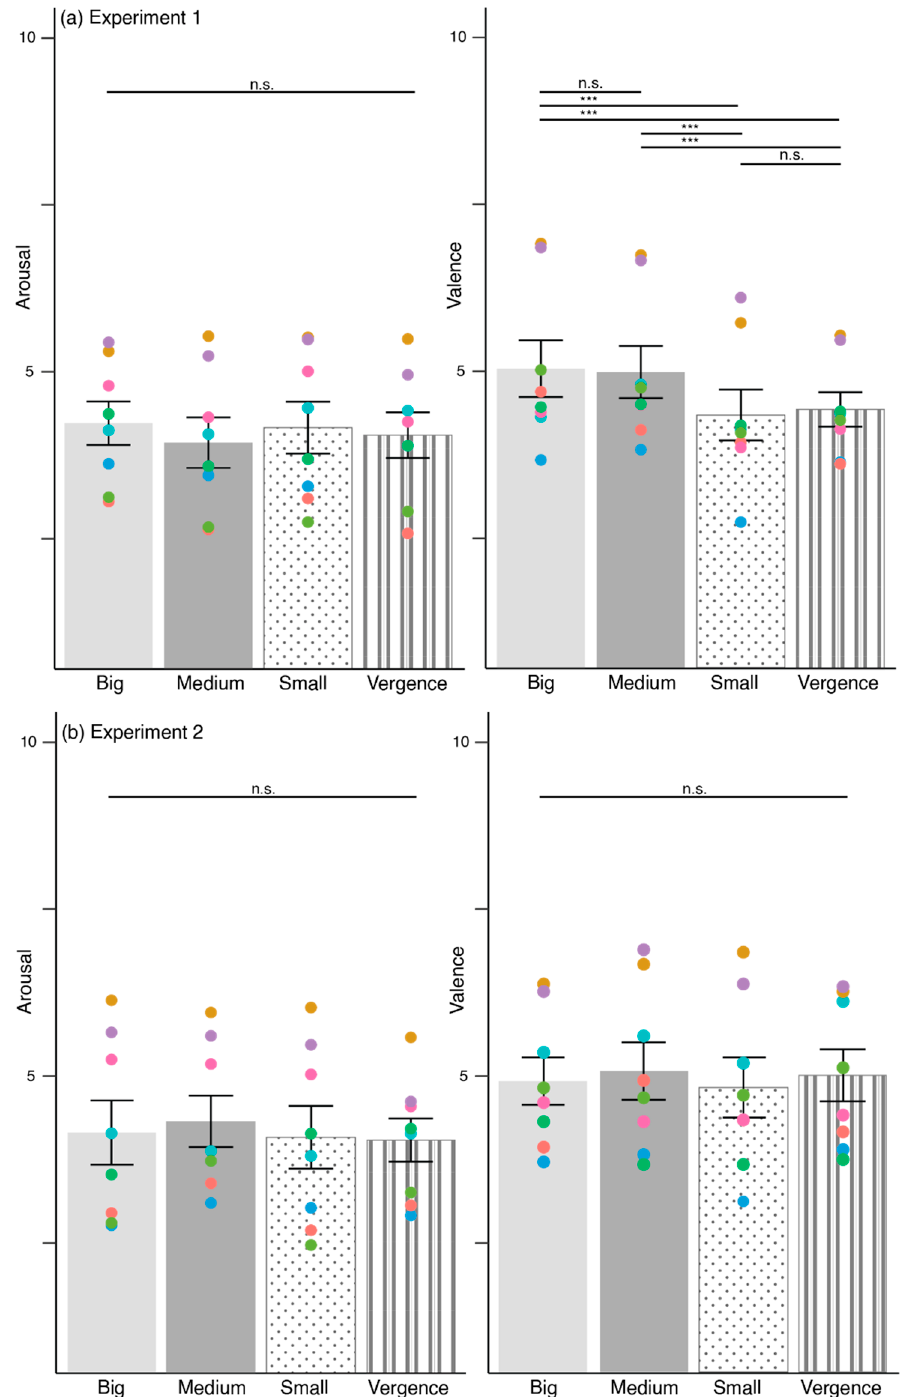
Figure 7. Arousal and valence ratings in ( a ) Experiment 1, and ( b ) Experiment 2 across big, medium, small, and vergence pupils. The colored scatter corresponds to each eye model. Error bars depict standard error of means, S.E.M. *** p < 0.001,